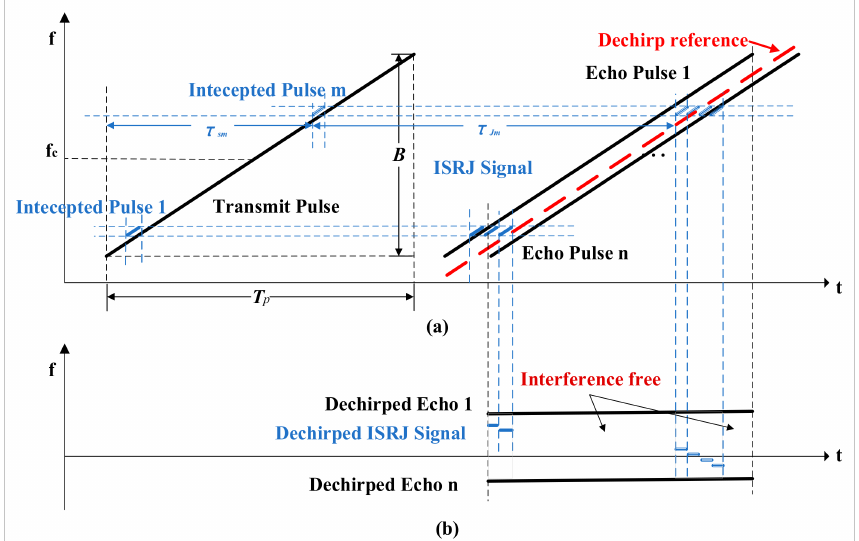
Figure 1. TF characteristics of the transmitted signal and received signals including echo and jamming. ( a ) TF characteristics of the transmitted signal and received signals before de-chirp; ( b ) TF characteristics of the received signals after